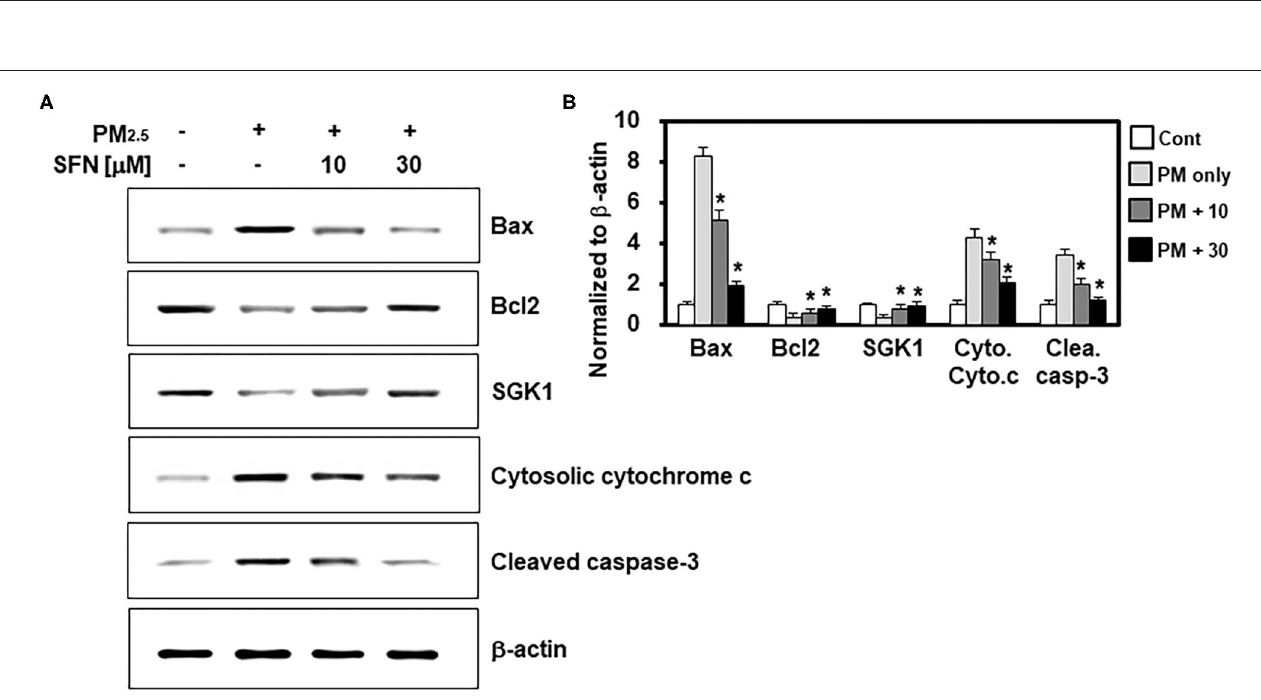
FIGURE 3 | Effects of Sulforaphane (SFN) on PM 2.5 -induced changes in apoptosis-related protein levels. (A) ARPE-19 cells were treated with the indicated concentrations of SFN or DEX (1 µ M) 24h after PM 2.5 challenge (100 µ g/mL). Subsequently, western blot analysis was conducted to measure Bax, Bcl-2, SGK1, cytochrome c, and cleaved caspase-3. β -actin was used as a loading control. Representative images from each group are shown ( n = 3). (B) The graphs show the densitometric intensities of each gene normalized to β -actin. n = 3 blots. * p < 0.01 relative to the control group, one-way ANOVA.